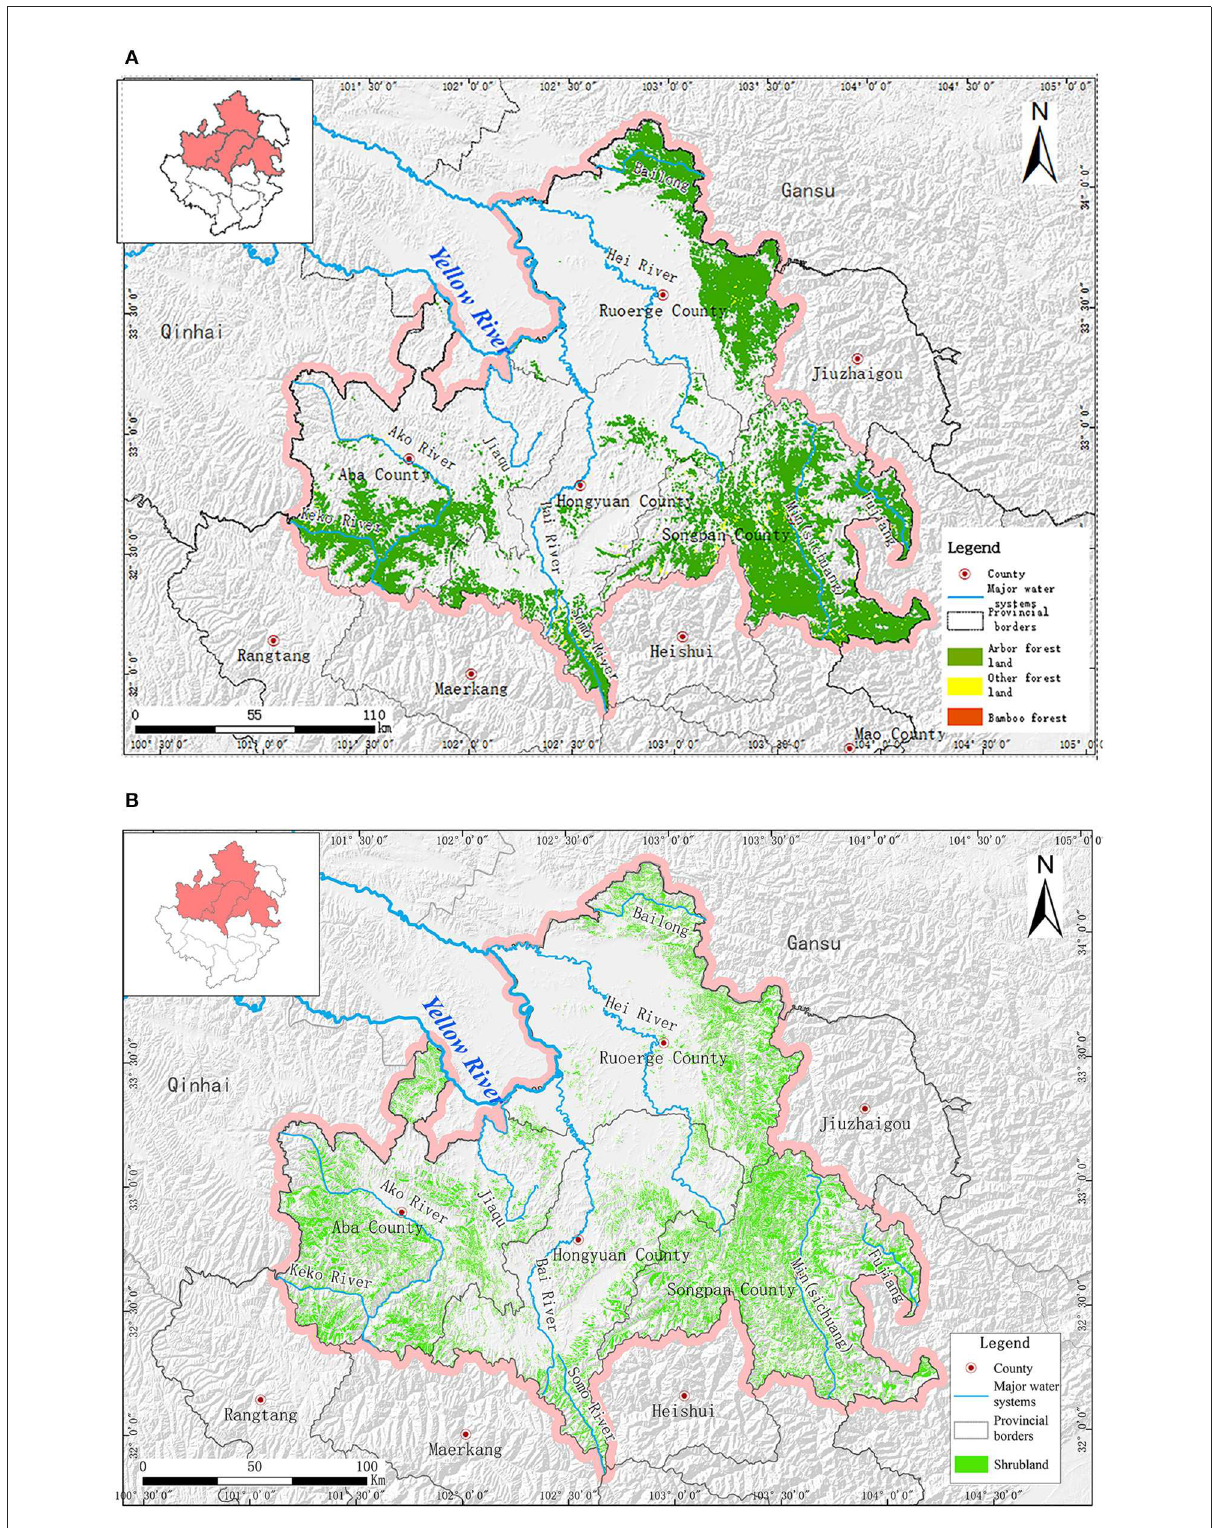
FIGURE4 Forest ecosystem distribution in the study area. (A) Arbor forest distribution. (B) Bushwood